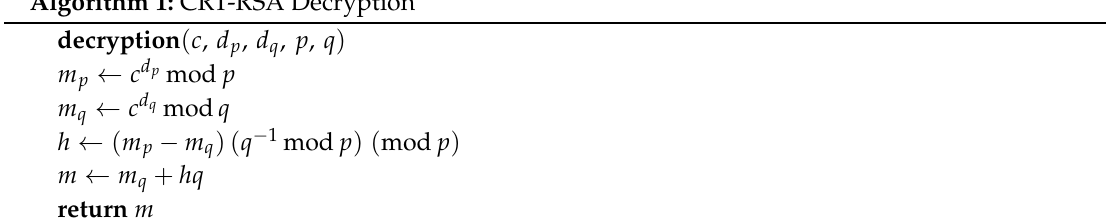
Algorithm 1: CRT-RSA